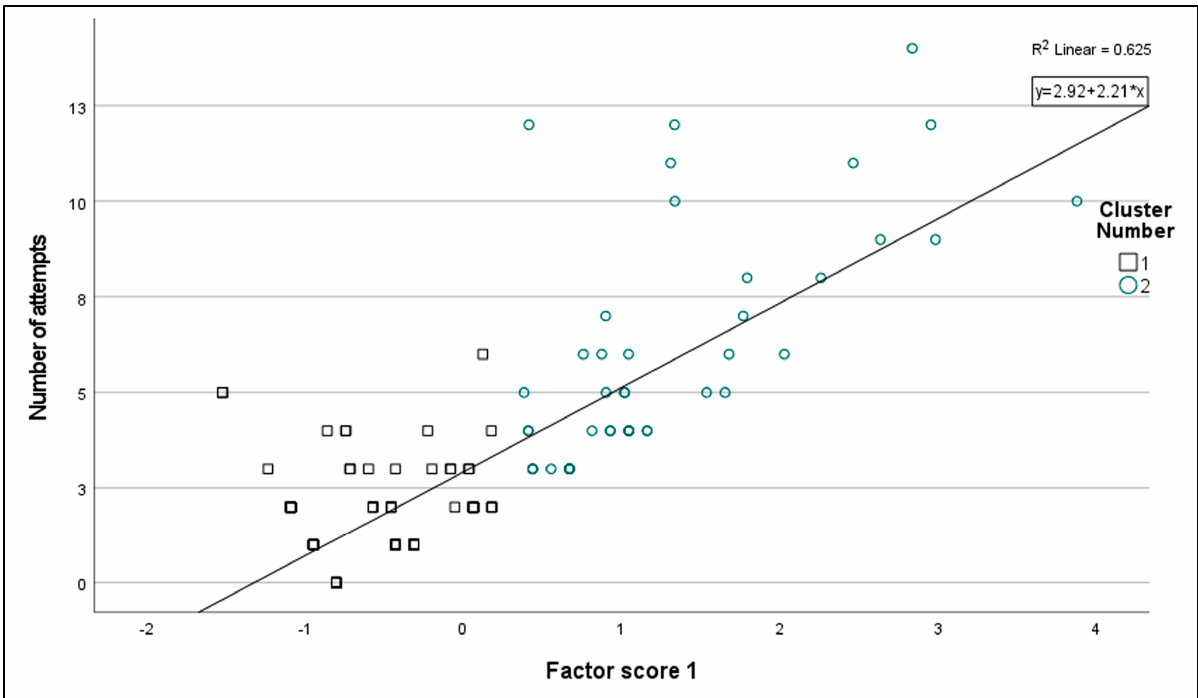
Figure 1. Separation of tests by foraging behavior type, based on the number of trials in each prey size category. The factor score 1 was obtained using PCA based on the number of attempts observed in each of the three prey-size categories. The two clusters were separated using a Two-Step cluster analysis. The GLM results show that the repeated tests had no significant effect ( p = 0.803) on the latency of the predation, although the effect of foraging clusters ( p < 0.001) and the interaction of repeated tests and clusters ( p = 0.001) were significant (Table 1). Table 1. The effect of repeated tests and foraging clusters on foraging latency (general linear model).